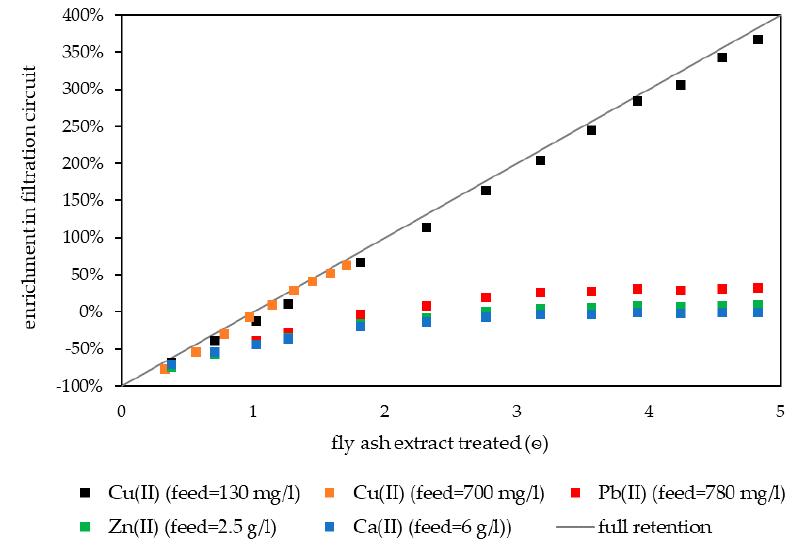
Figure 6. Enrichment of Cu(II), Pb(II), Zn(II), and Ca(II) in filtration circuit during continuous Cu(II) retention treating fly ash extracts from MVA Ingolstadt. The process was started with water in the filtration circuit, resulting in an arithmetically negative enrichment. Reference: concentration in the fly ash extract. HB-PEI = 4 g L − 1 , pH 3.0, T = 40 °C.